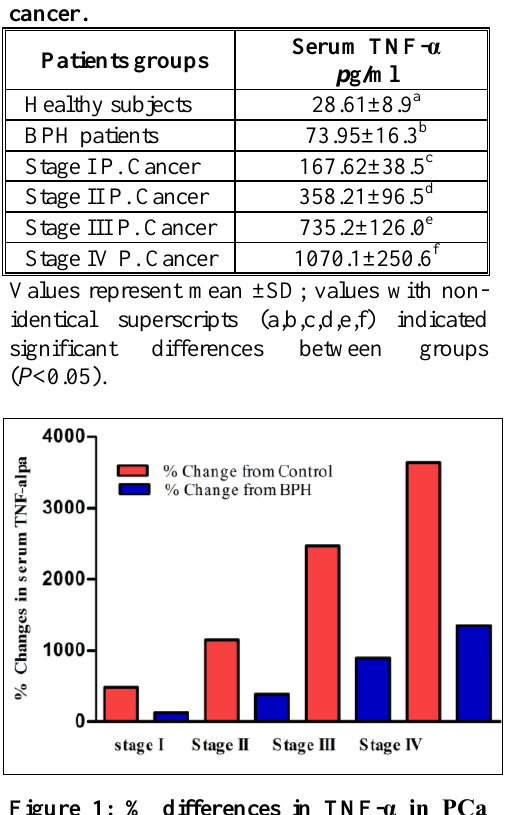
Figure 1: % differences in TNF-α in PCa patients with different stages of the disease compared to BPH patients and